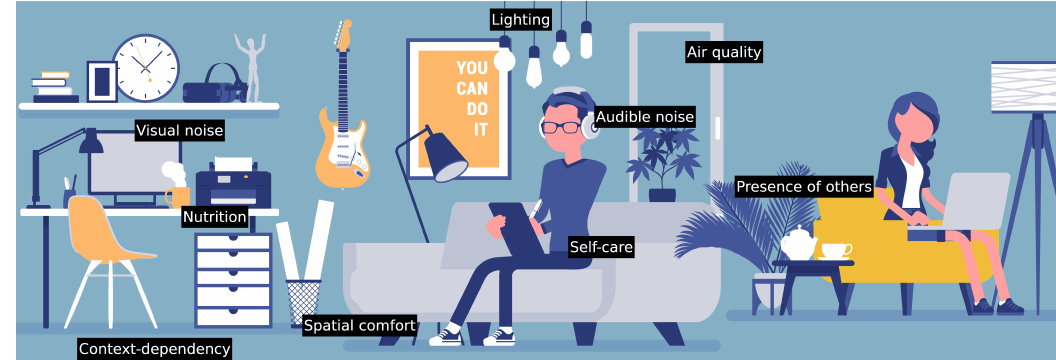
Figure 1. This figure illustrates an exemplary learning space with nine flagged factors that can effect learning. The factors identified through a literature search and flagged here are visual noise, audible noise, context dependency, air quality, nutrition, lighting, spacial comfort, self-care, and presence of others. (From stock.adobe.com by